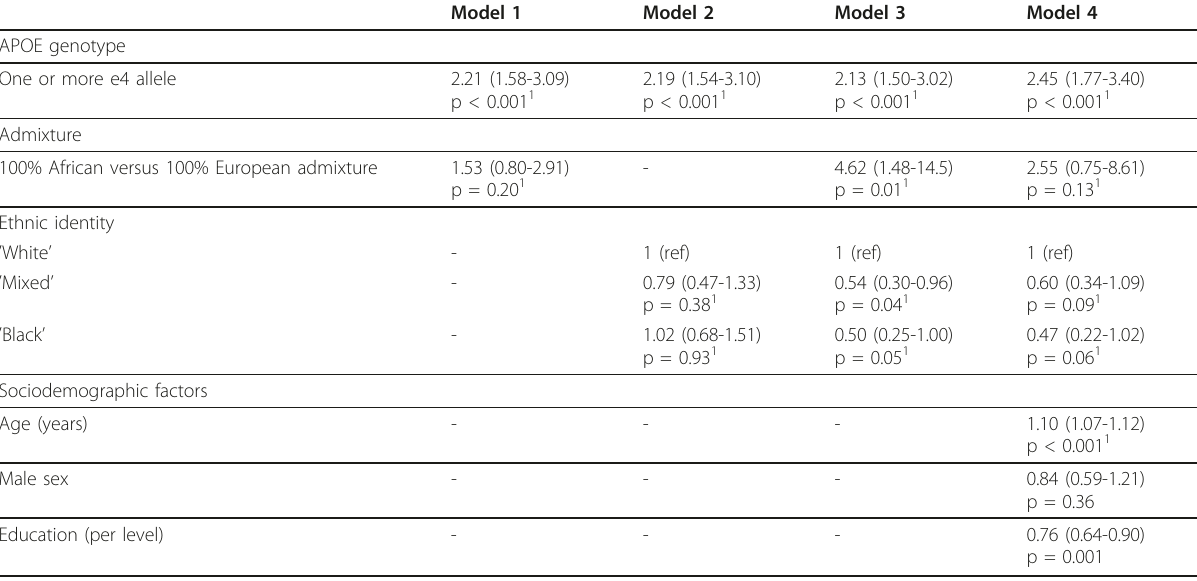
Table 5 The independent effects of admixture and ethnic identity upon dementia prevalence (weighted